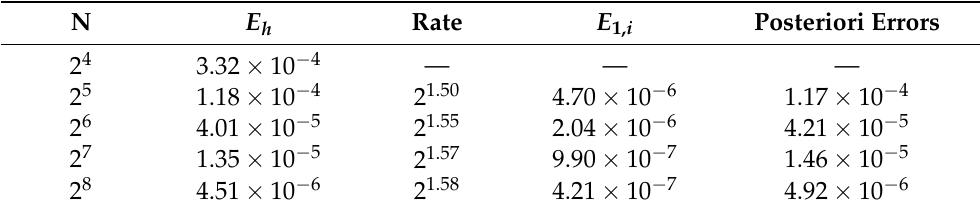
Table 1. Numerical results at t = 0.4 of Example 1.